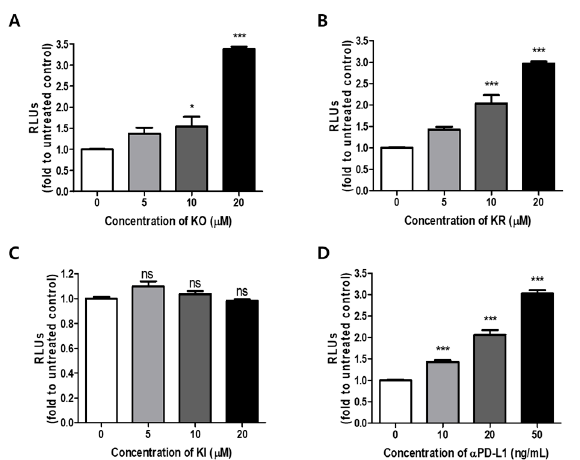
Figure 3. Effects of KO and its glycosides in cell-based PD-1/PD-L1 blockade assay. Effect of ( A ) KO, ( B ) KR, ( C ) KI and ( D ) aPD-L1 on T-cell receptor (TCR)-mediated nuclear factor of activated T cells (NFAT) activity by the PD-1/PD-L1 blockade in a co-cultured system. PD-1 Jurkat effector cells and PD-L1/aAPC CHO-K1 target cells were co-cultured with each compound for 24 h at the indicated concentrations. The activation of PD-1 Jurkat cells led to the level of NFAT-luciferase (for details, see Materials and Methods). Data are presented as means ± S.E. (standard error) values of three representative independent experiments. Asterisks indicate significant upregulation of relative luminescence units (RLUs) by each sample as compared with the control group (* p < 0.05 and *** p < 0.001; ns: not significant).